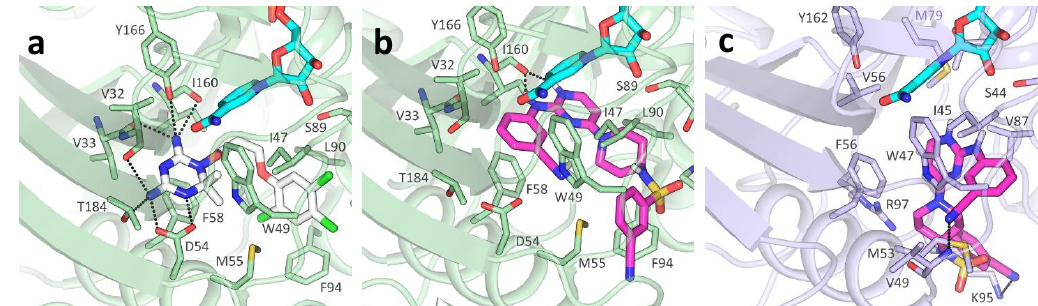
Figure 7. TCMDC-143249 docking poses in Tb and Lm DHFR ( a ). Pyrimethamine inhibitor (white) main polar contacts in PDB ID 3RG9. Docking pose of TCMDC-143249 (magenta) in Tb DHFR ( b ), and in Lm DHFR model ( c ). Protein is represented as cartoon ( Tb DHFR, light green; Lm DHFR, violet), with relevant binding site residues depicted as sticks and labelled. NADPH cofactor (cyan) and ligands are shown as capped sticks. For clarity, polar hydrogens are shown for ligands only.